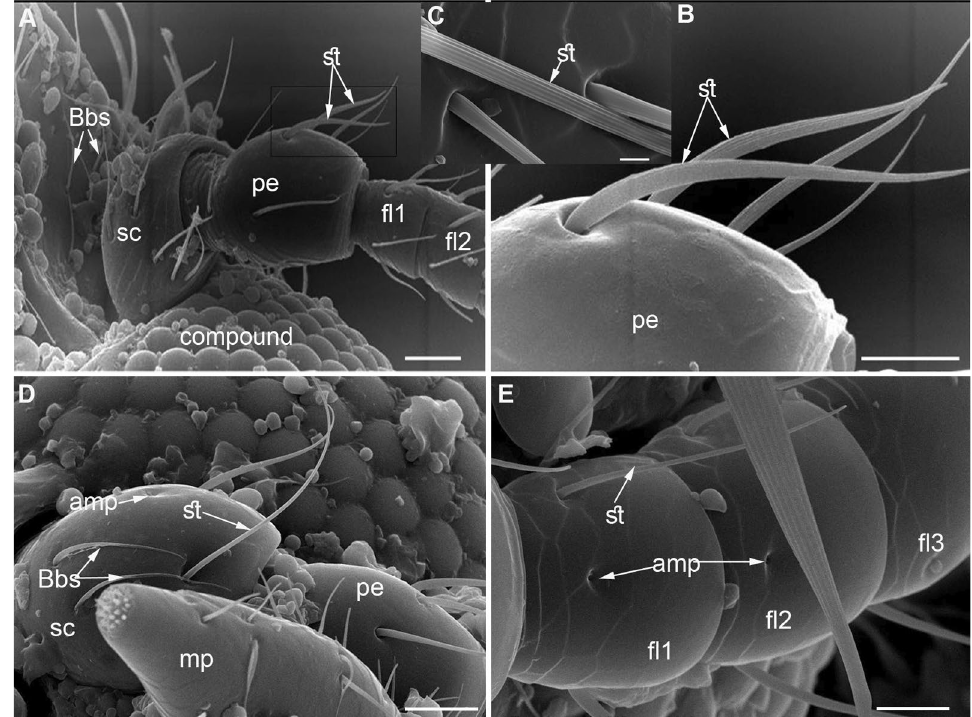
Fig. 2 Scanning electron micrographs of the basal part of the antenna of adult Rhyzopertha dominica . A The scape (sc) bears a group of s. trichodea (st) and Böhm’s sensilla (Bbs), pedicel (pe) and two basal flagellomeres (fl1 and fl2) bears grooved sharp tipped s. trichoid sensilla (st). B The pedicel (pe) with s. trichodea (st) fit into depressed cuticle. C Enlarged part of s. trichodea showing the longitudinally grooved shafts. D Scape (sc) and pedicel (pe), showing one dorsal s. ampullacea (amp) on the scape. E The three basal flagellomeres (f1-f3) of the flagellum carrying s. trichodea (st) and ampullacea (amp). Scale bars: A and B 10 µm; C 2 μm; D 20 μm; E 10 μm